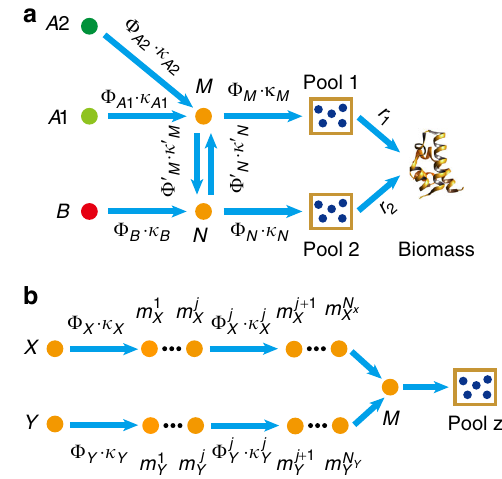
Fig. 2 Topology of the metabolic network. a Coarse-grained model of the metabolic network. Group A carbon sources merge to a common node M before reaching precursor pools. Group B sources can supply some precursor pools from other routes. b Topology of the part of the metabolic network connecting two carbon sources to a precursor pool. The two carbon sources X and Y (from Group A and/or Group B) reach a common node M through multiple intermediate nodes (metabolites) m j X and m j Y along their respective pathway, after which the fl ux is diverted to Pool